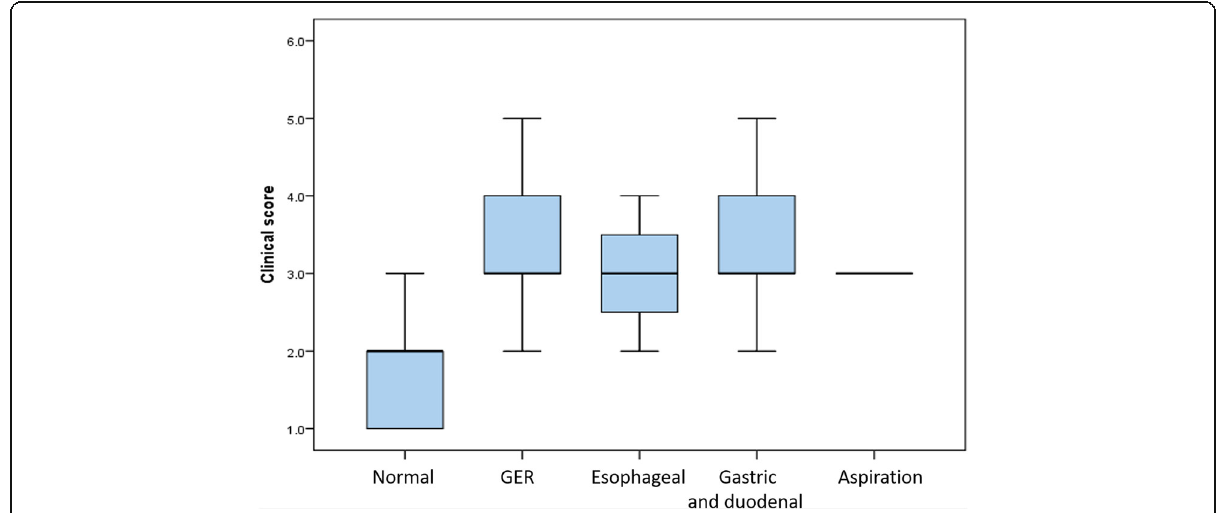
Fig. 9 The calculated clinical score in different study